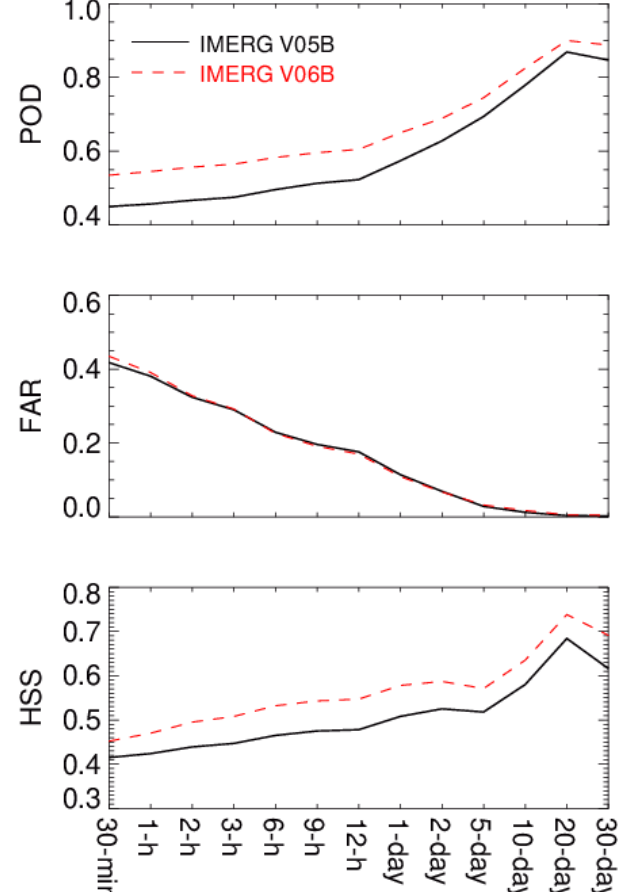
Figure 4. POD, FAR and HSS as functions of the time scale. The precipitation/no-precipitation threshold is set to 0.1 mm h − 1 .